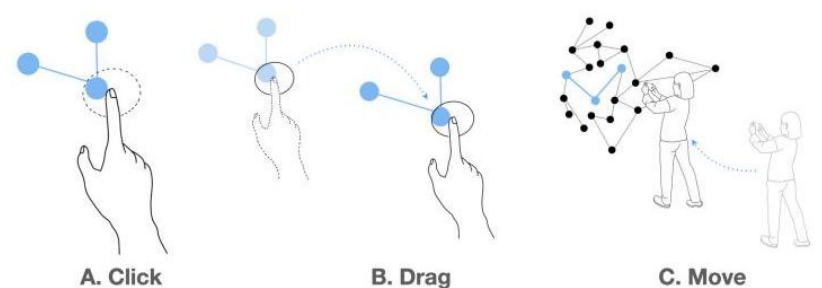
Figure 2. Interaction paradigms.